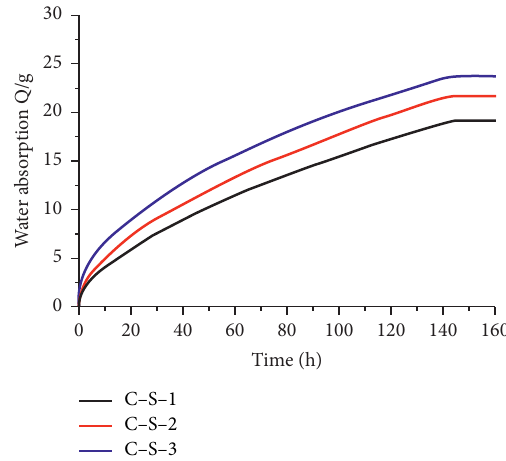
Figure 3: Water absorption characteristic curves for three sand- stone